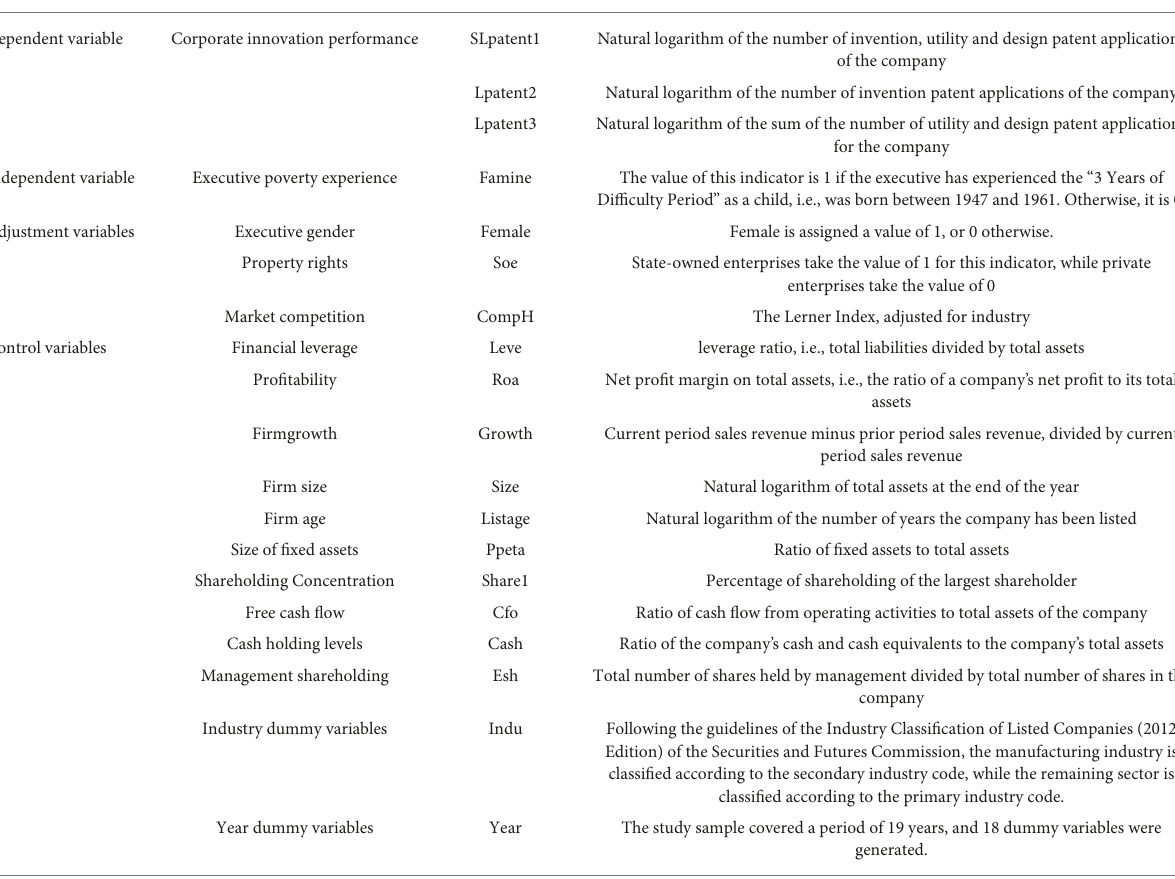
TABLE 1 Variable definitions.